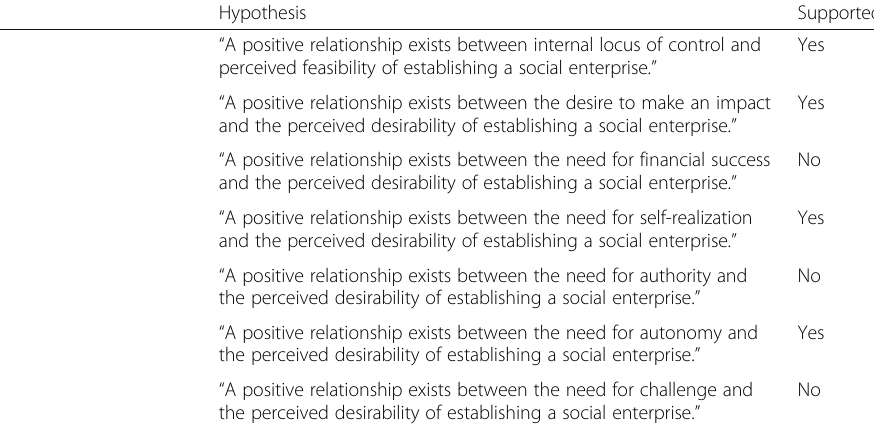
Table 2 Tabulated synthesis of results across different studies (Continued) Hypothesis Supported?